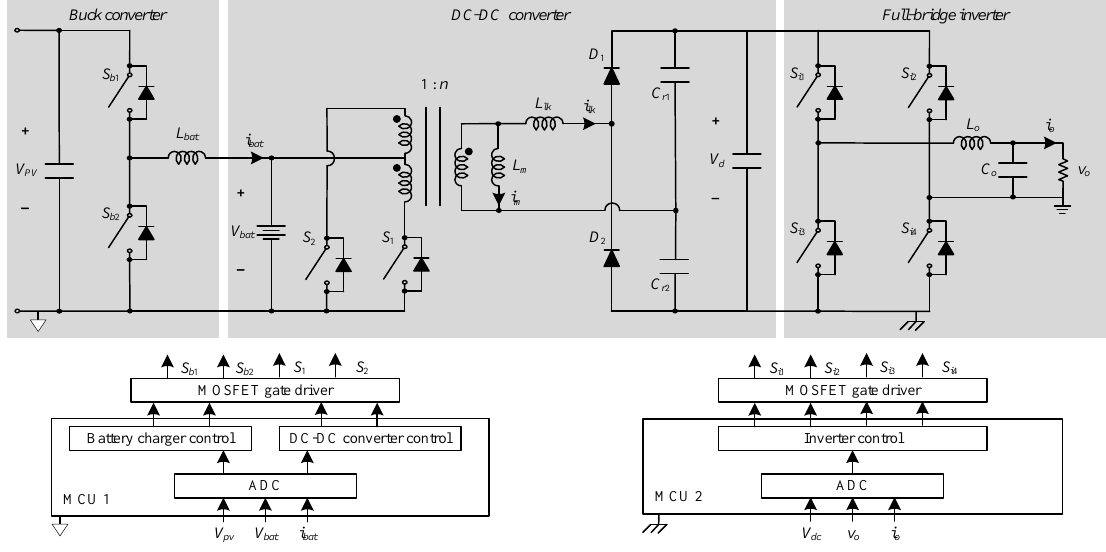
Figure 6. Overall system diagram of the PV standalone converter with the simple controller.